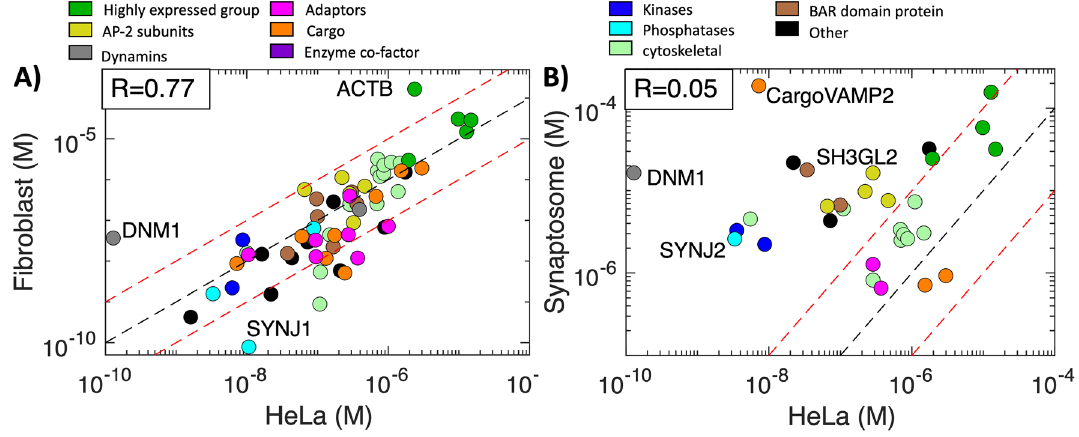
Figure 4. Concentrations vary by orders of magnitude across the CME proteome, with strong correlation between HeLa and Fibroblast cells. ( A ) Most proteins in Fibroblast cells are within a factor of 10 (dashed red lines) compared to HeLa cells, R = 0.77. Correlations are always applied to log10 values. ( B ) In synaptosome, although the highly expressed proteins (green: actins, clathrin heavy chain, cofilin, Hsc70) are still correlated, most proteins are significantly more abundant in synaptosomes relative to HeLa. R = 0.05. Proteins with zero copies in a cell type (e.g. SNAP91/AP180 in HeLa) or unknown copies are not shown. Importantly, although the AP-2 subunits are more abundant in synaptosomes (yellow dots), they no longer outnumber the majority of proteins, as they do in the other cell types. Outliers are labeled. DNM1 has a markedly lower concentration in HeLa than either fibroblast or synaptosome. Lipid phosphatases SYNJ1 and SYNJ2 have widely varying concentrations, with SYNJ2 and SH3GL2 (endophilin A1) much more concentrated in